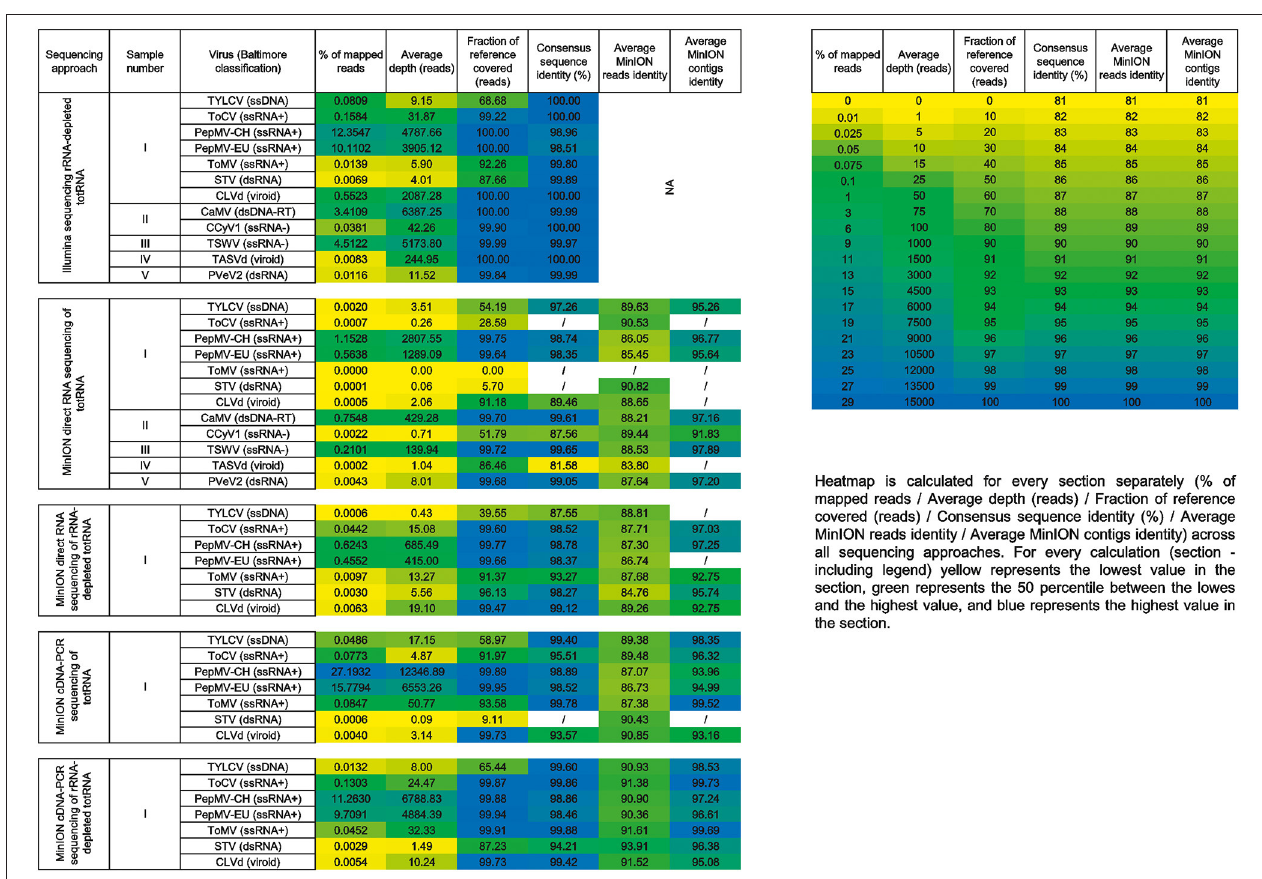
FIGURE 2 | Heatmap of the samples included in the comparison with corresponding results: percentage of mapped reads, average depth (reads), fraction of reference covered (reads), consensus sequence identity (%), and average MinION reads/contigs identity (/ no data; NA not